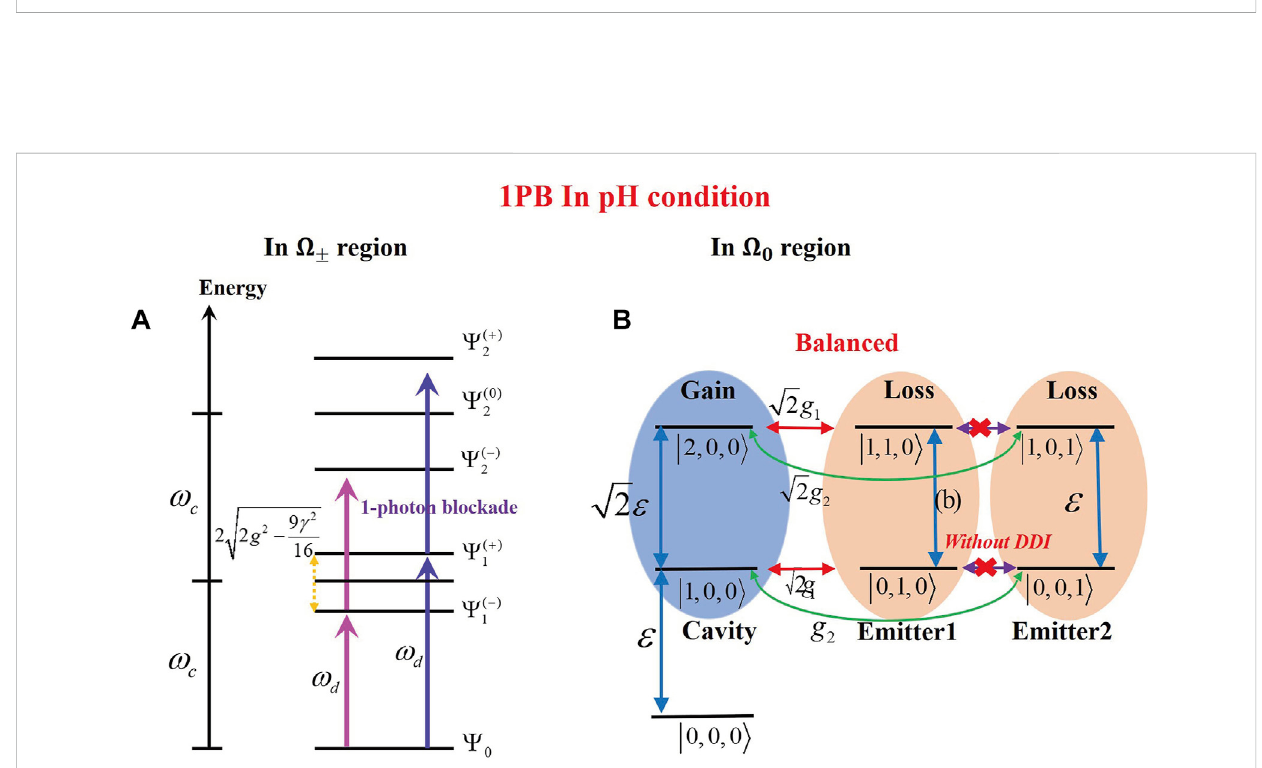
FIGURE 12 ExplanationofthePBeffect ofthenon-Hermitiansysteminthepseudo-Hermitian condition for differentregions: (A) inthe Ω ± region and (B) inthe Ω 0